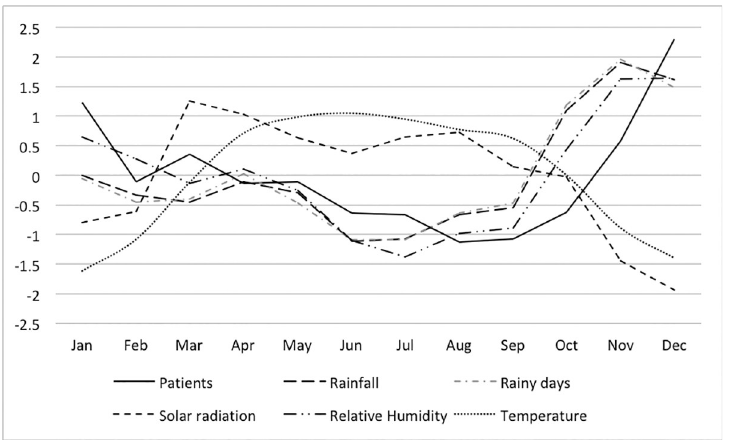
Fig 3. Monthly distribution of the standardized incidence of leptospirosis cases and meteorological parameters in the dry zone of Sri Lanka.